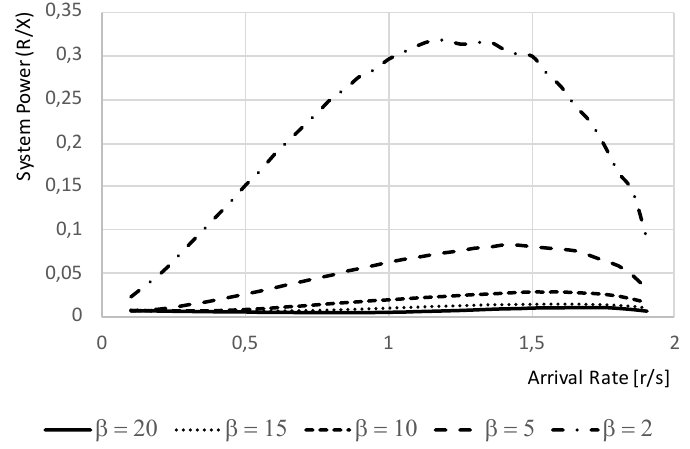
Figure 23. System power vs. arrival rate of requests for various values β of the batch sizes of Urgent